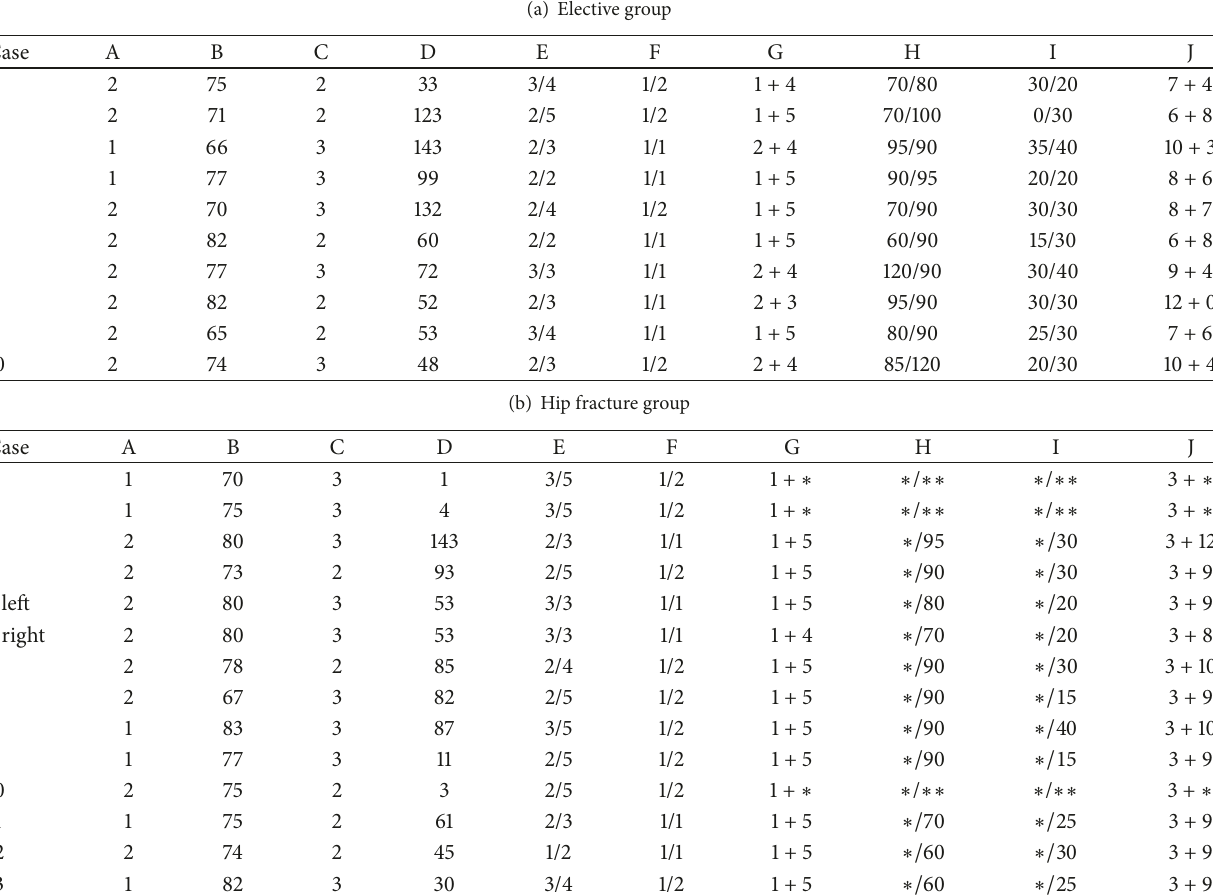
Table 3: Details of patients included in the